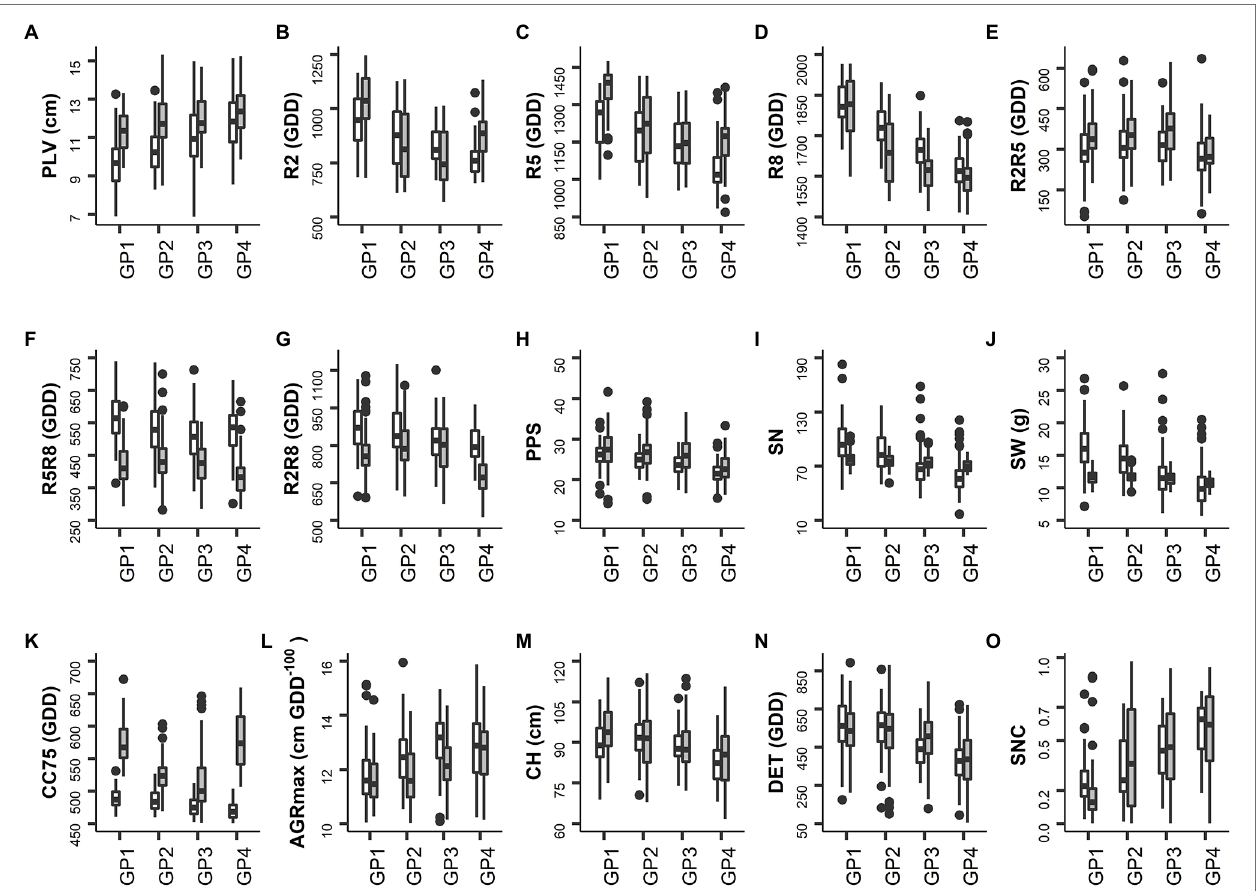
FIGURE 2 | Distribution of the BLUP values per trait in the control field. White and gray shaded whiskers represent values for 2018 and 2019, respectively. Labels on the X -axis represent the four groups of accessions with different sowing moments (for details see Materials and Methods). (A) PLV: Plant length up to the second node. (B) R2: Thermal time from sowing to full flowering. (C) R5: Thermal time from sowing to beginning seed. (D) R8: Thermal time from sowing to pod maturity. (E) R2R5: Duration of pod formation. (F) R5R8: Duration of seed development. (G) R2R8: Thermal time from full flowering to pod maturity. (H) PPS: Number of pods on main stem. (I) SN: Number of seeds per plant. (J) SW: Seed weight per plant. (K) CC75: Thermal time to canopy cover 75%. (L) AGRmax: Maximum absolute growth rate. (M) CH: Maximum canopy height. (N) DET: Degree of indeterminacy. (O) SNC: Rate of